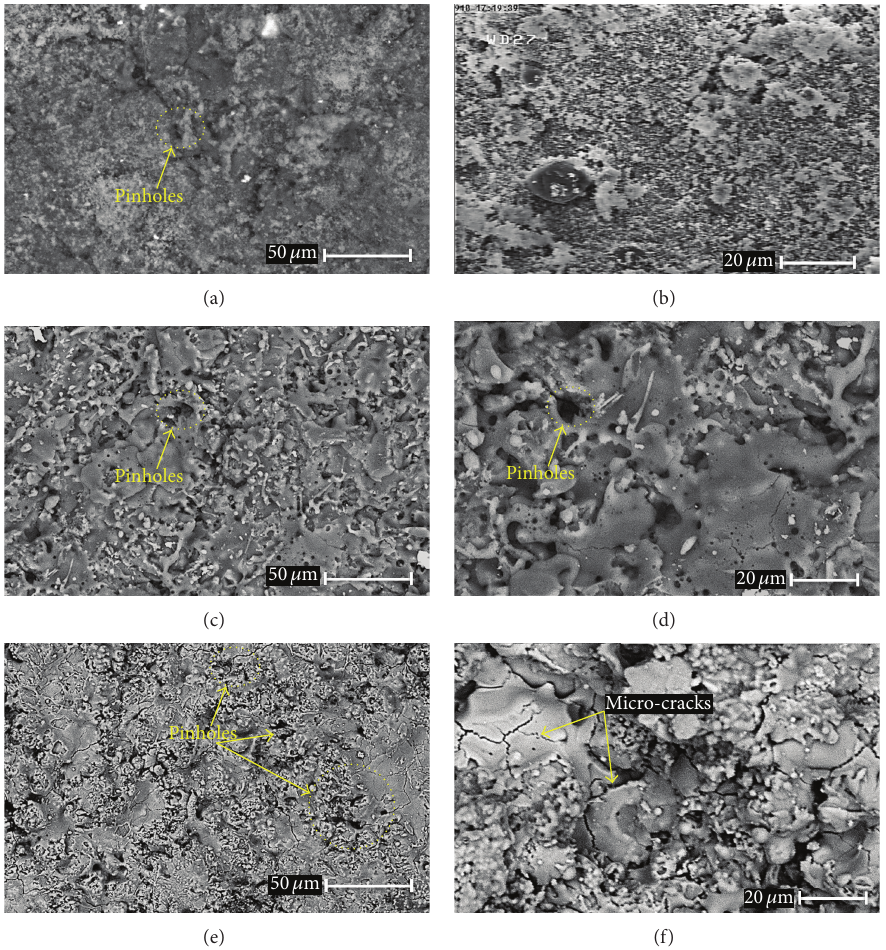
Figure 5: Surface morphology of the as-sprayed coatings: (a, b) nanostructured Al 2 O 3 layer, (c, d) normal Al 2 O 3 layer; and (e, f) normal YSZ